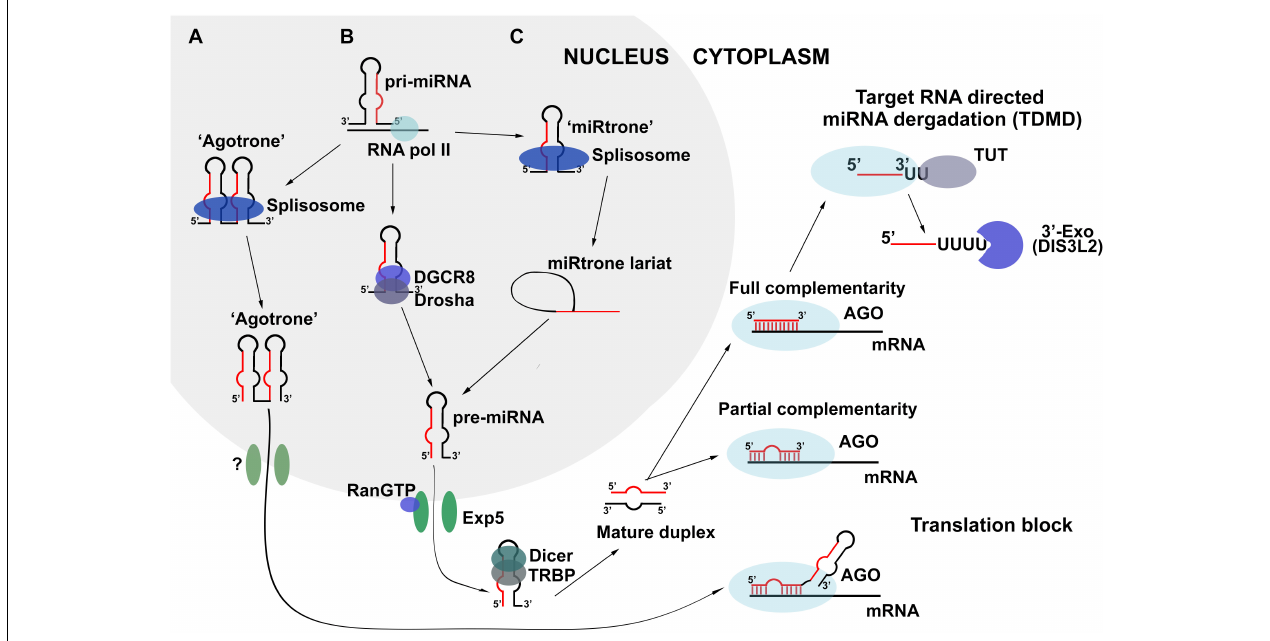
FIGURE 1 | Biogenesis and turnover of miRNA in the cell. (A,C) Non-canonical schemes of biogenesis: Drosha/Dicer-independent and Drosha-independent, respectively; (B) Canonical Drosha/Dicer-dependent scheme of miRNA